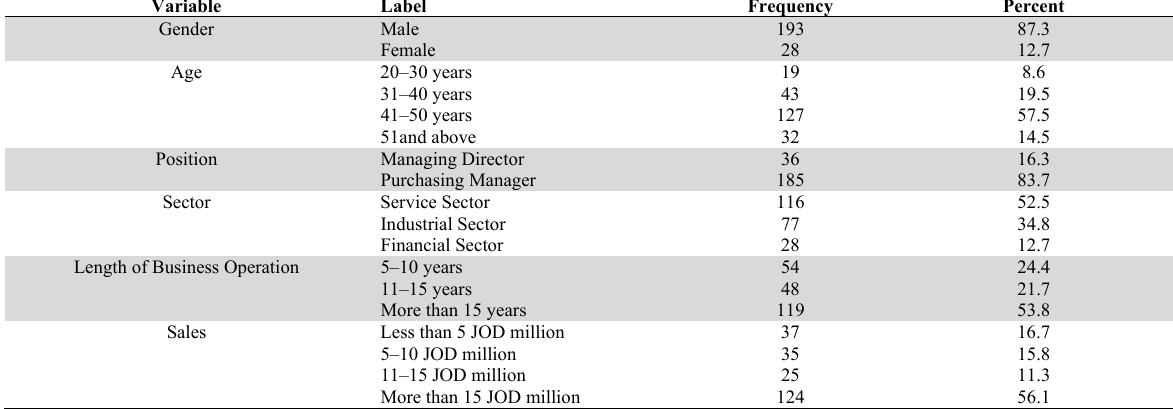
Profiles of Sampled Companies and Respondents’ Demographic Information.